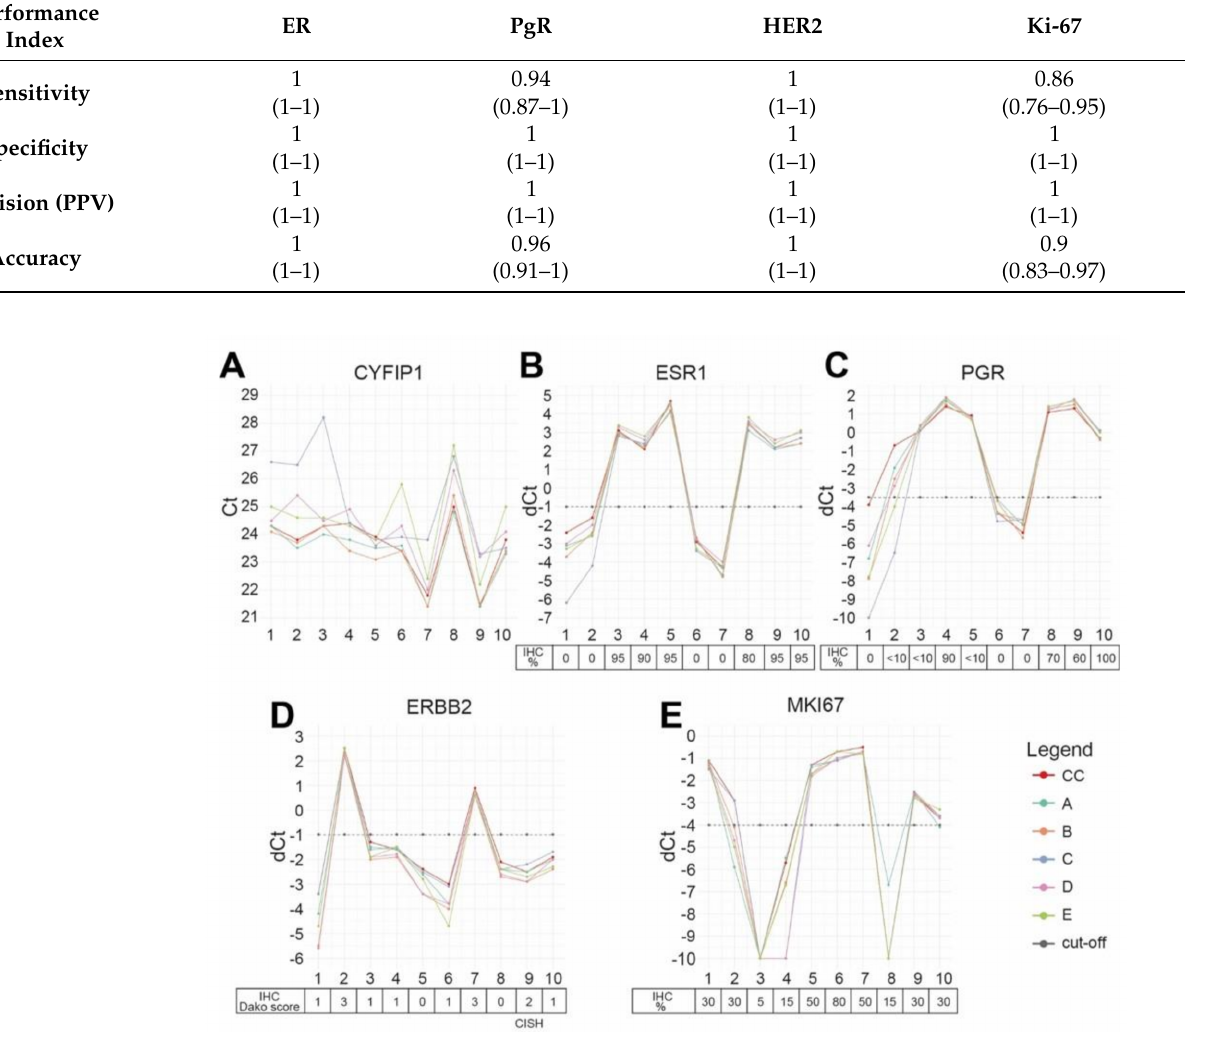
Figure 1. STRAT4 semi-quantitative mRNA level measurements for the reference gene and the four markers of interest. ( A ) Cytoplasmic FMR1-interacting protein 1 ( CYFIP1 ) cycle threshold (Ct) measurements across the coordination center (CC) and the five participating sites A–E. ( B – E ) Delta cycle threshold (dCt) measurements for the markers across CC and the five participating sites A–E: ( B ) estrogen receptor ( ESR1 ); ( C ) progesterone receptor ( PGR ); ( D ) human epidermal growth factor receptor ( ERBB2 ); ( E ) Ki-67 ( MKI67 ). Cut-off: dCt cut-off utilized by the STRAT4